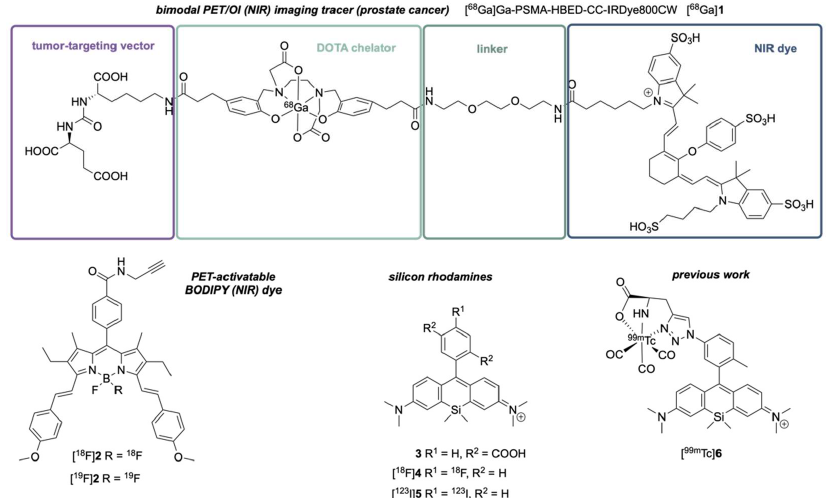
Figure 1. The PET-activatable moiety (DOTA chelator to complex gallium-68) and the NIR dye (IRDye800CW) are separated in the PSMA-targeting bimodal (PET/OI) imaging tracer 1 . In contrast, the bis-styrene BODIPY dye 2 can be PET-activated itself and possesses a significantly reduced molecular weight as a bimodal imaging tracer conjugate. SiR dyes like 3 are NIR dyes with an even lower molecular weight than 2 . However, PET- or SPECT-activation of 4 , 5 , and 6 could not be achieved via an isotope exchange reaction.